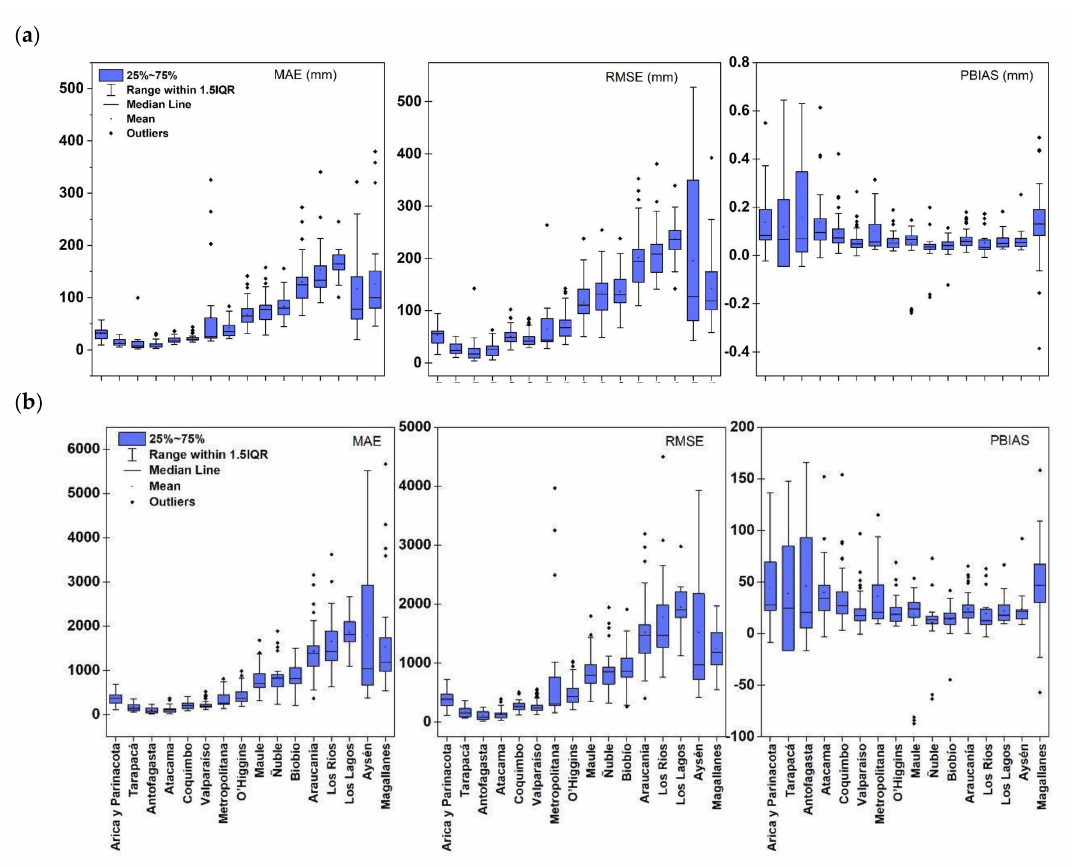
Figure 11. Boxplot of gauge-IMERG Early product for ( a ) Monthly and ( b ) Yearly errors. 25% and 75% represent the distribution that has an index between the 25th percentile (P25) and 75th percentile (P75), the horizontal line inside the box shows the median, the mean value is included with a black circle, and the so-called “whiskers” mark the maximum and minimum values that are not outside the typical range of the distribution. Outliers are shown with a black